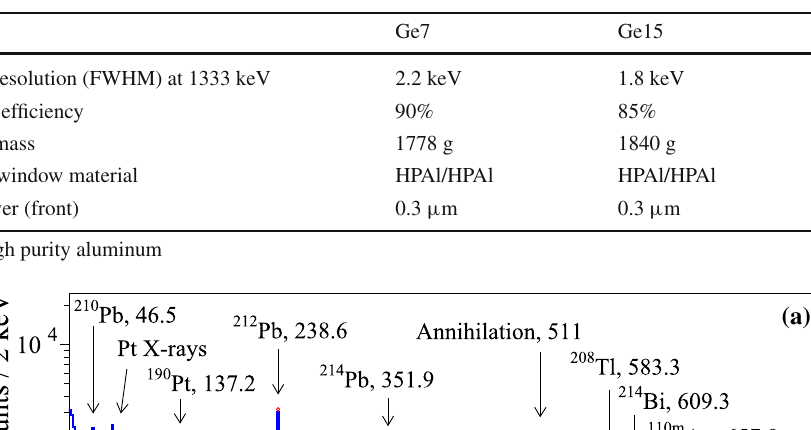
Table 2 Properties of the HPGe-detectors used in the present experiment. FWHM denotes the full width at half of maximum of γ -ray peak